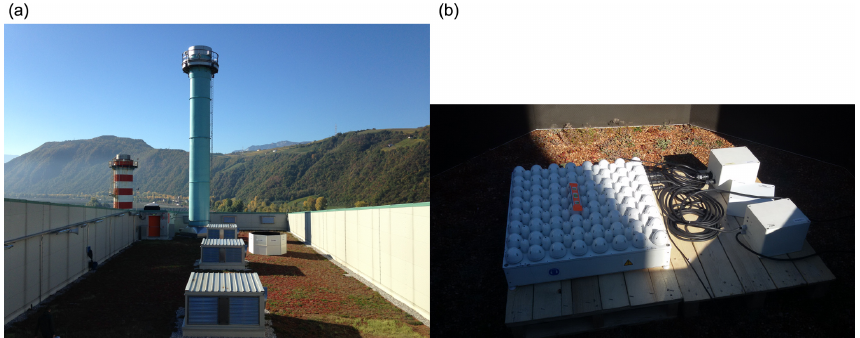
Figure 3. A view of the roof of the incinerator of Bolzano during the experimental campaign with the MFAS mini-sodar (a) and the detail of the antenna (b)